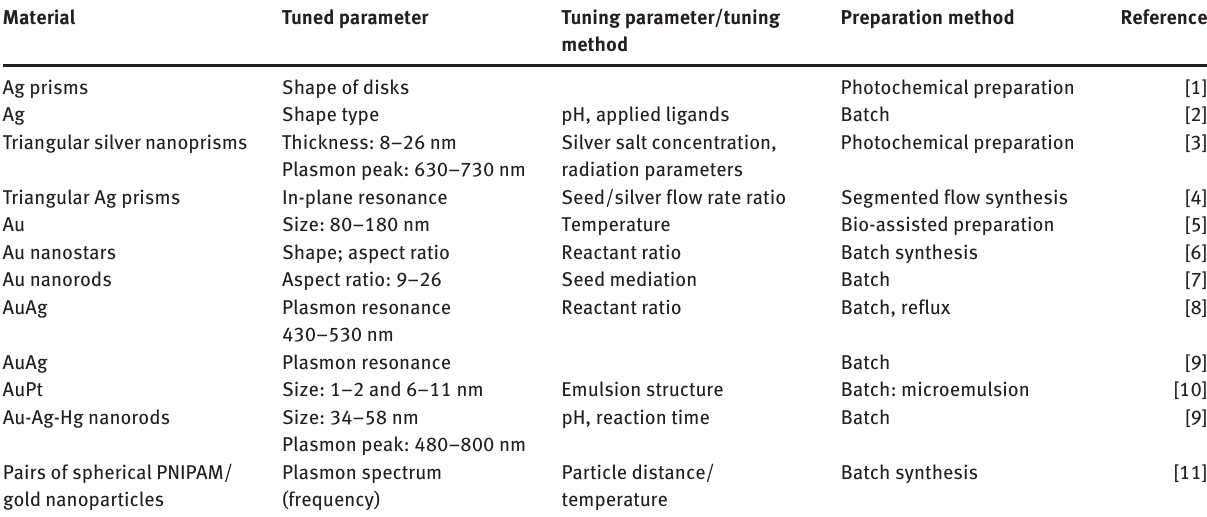
Table 1 Tuning of properties of selected metal